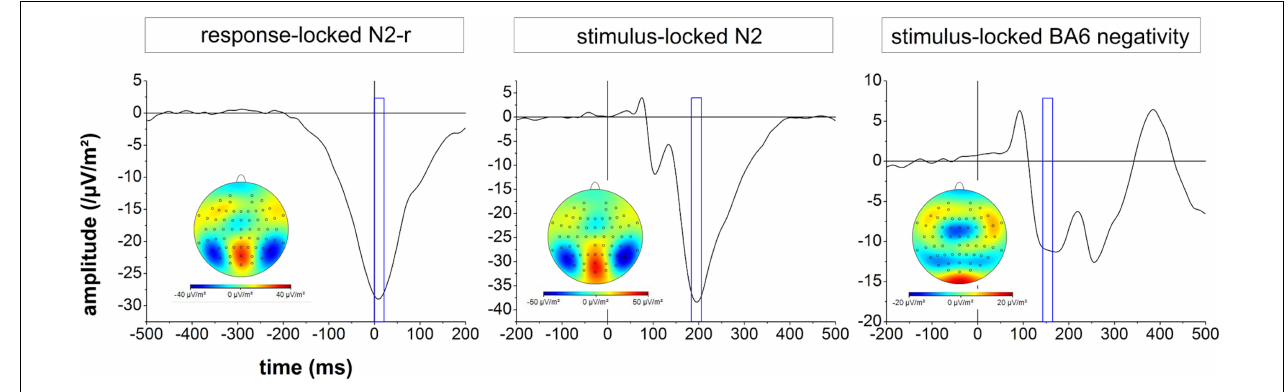
FIGURE 1 | Temporal profile and cortical mapping of the event-related potentials (ERPs) of interest (response-locked N2 = left figure, stimulus-locked N2 = middle figure, stimulus-locked BA6 negativity = right figure). The blue box reflects a time window of 10 ms for the calculation of the cortical mappings. Please note that the different scaling for the mappings is due to variations in ERP amplitude.